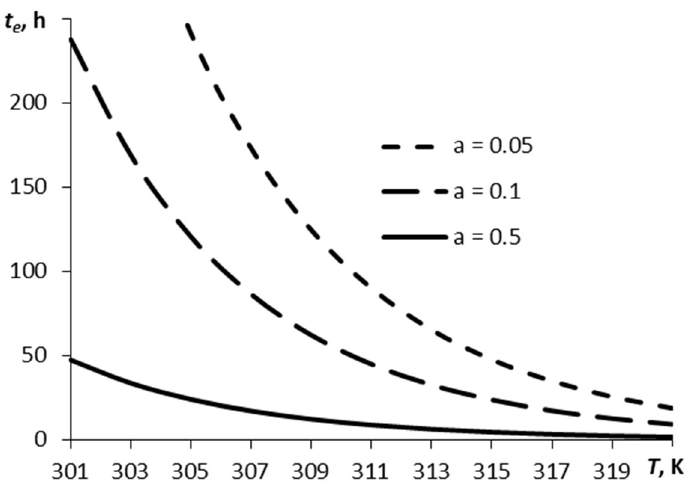
Figure 2. A typical time of sublimation plotted against temperature for different values of parameter α (RDX).